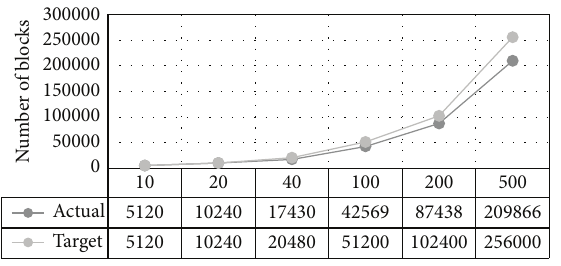
Figure 16: Effect of increasing the number of servers on download time.